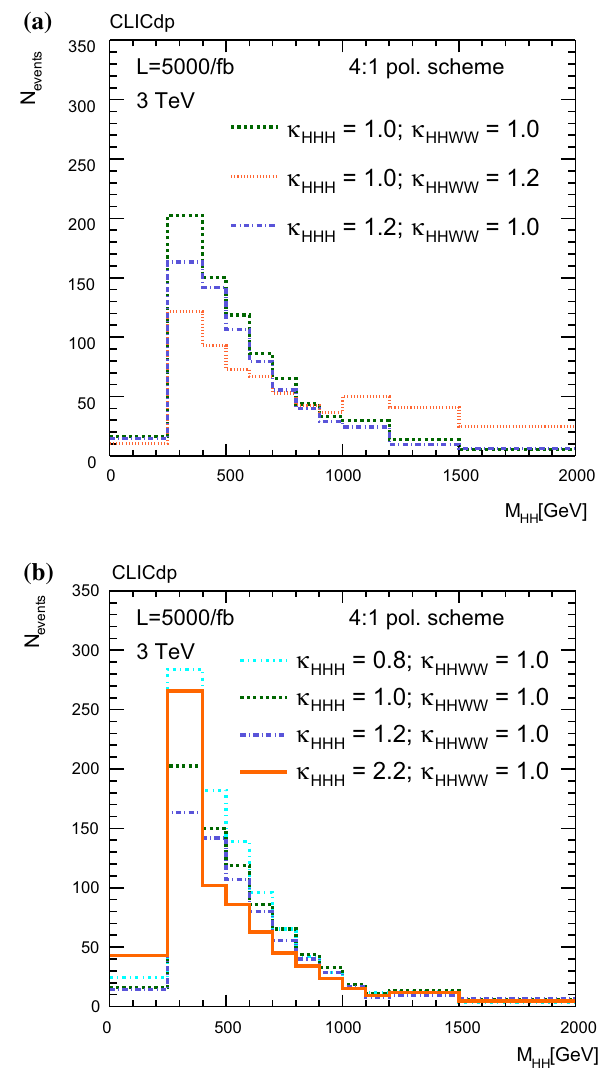
Fig. 7 Invariant mass of the Higgs pairs for the signal contributions with different values of κ HHH and κ HHWW in the loose BDT region. a Comparing samples with one of the couplings fixed to the SM value. b Comparing samples with κ HHH < 1 and κ HHH > 1. The sample with κ = 2 . 2 has roughly the same total cross section as the SM case HHH